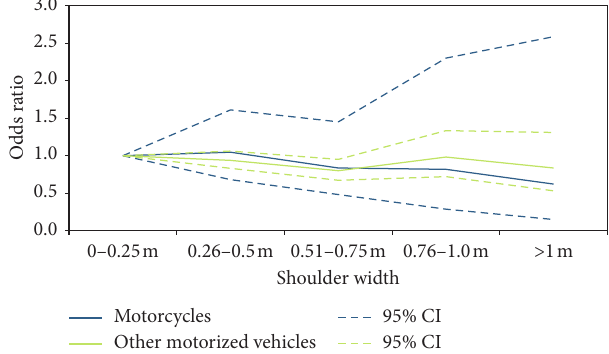
Figure 4: Odds ratio for shoulder widths. Motorcycles and other motorized vehicles (including data from